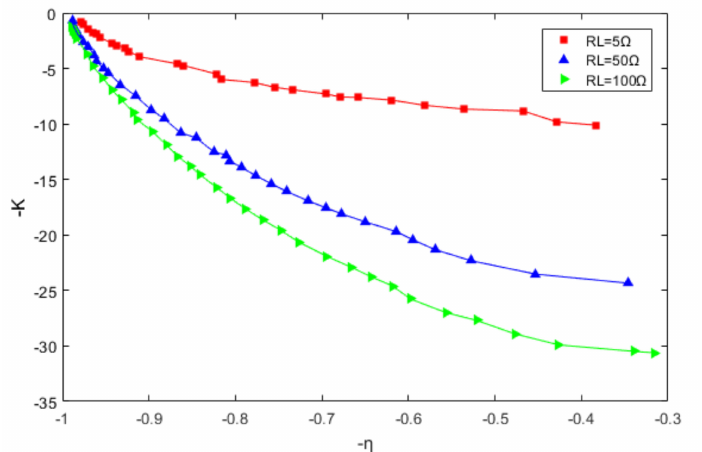
Figure 13. Pareto front curves under different load resistance.